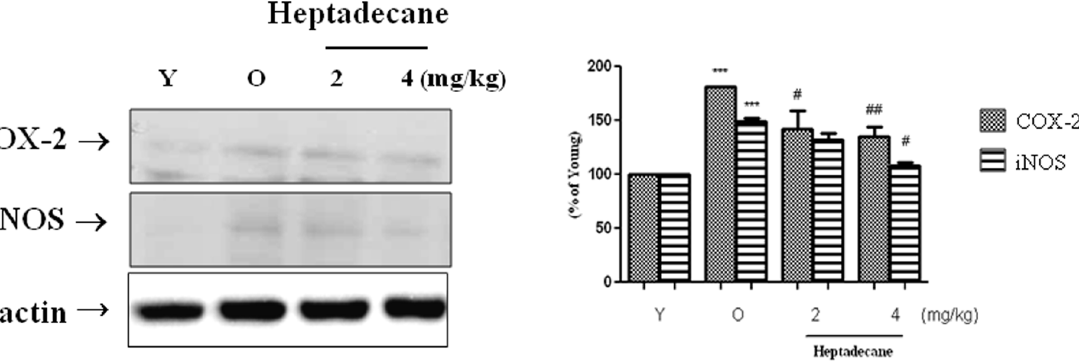
Figure 3. Heptadecane suppressed expressions of NF-kB-dependent genes in aged rats. Western blot was performed to detect renal COX-2 and iNOS levels in cytoplasmic extracts (40 m g protein) from young, aged, and aged rats fed heptadecane. One representative blot of each protein is shown from three experiments that yielded similar results, respectively. Young rats (9 months of age) and aged (20 months of age) were utilized. Heptadecane was fed to aged rats at 2 mg or 4 mg/Kg per day for 10 days. Statistical significance: results of one-factor ANOVA: ***p , 0.001 vs. young rat; # p , 0.05, ## p , 0.01 vs. old non-heptadecane-fed rats, respectively.